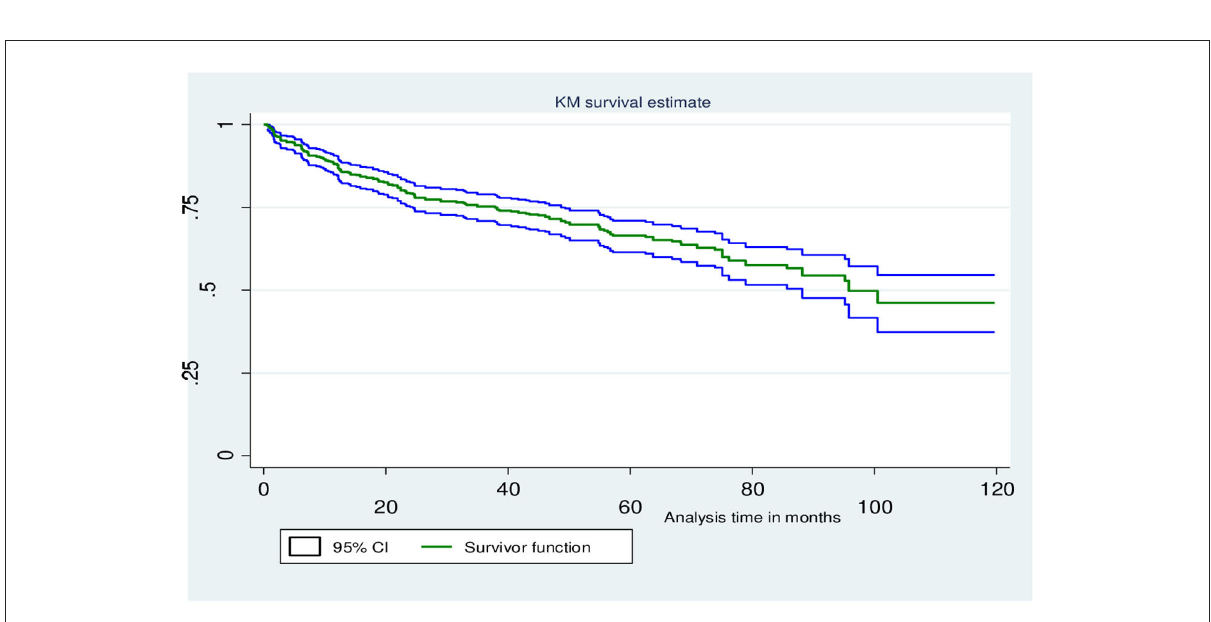
FIGURE3 KM survival curves illustrate the probability of OI-free survival over follow-up time for the cohort after the initiation of ART at WSUCSH, 2012–2021.